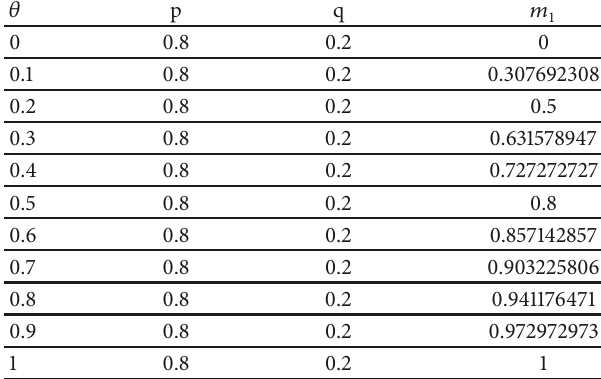
Table 4: The effect of 𝜃 on 𝑚 1